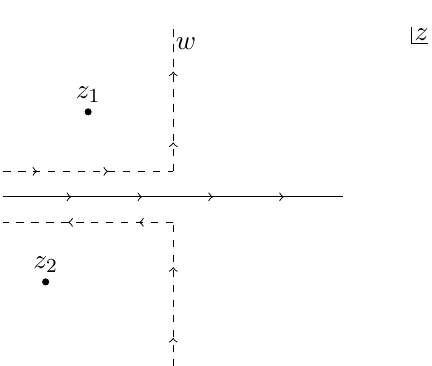
at order g . The solid hori- I